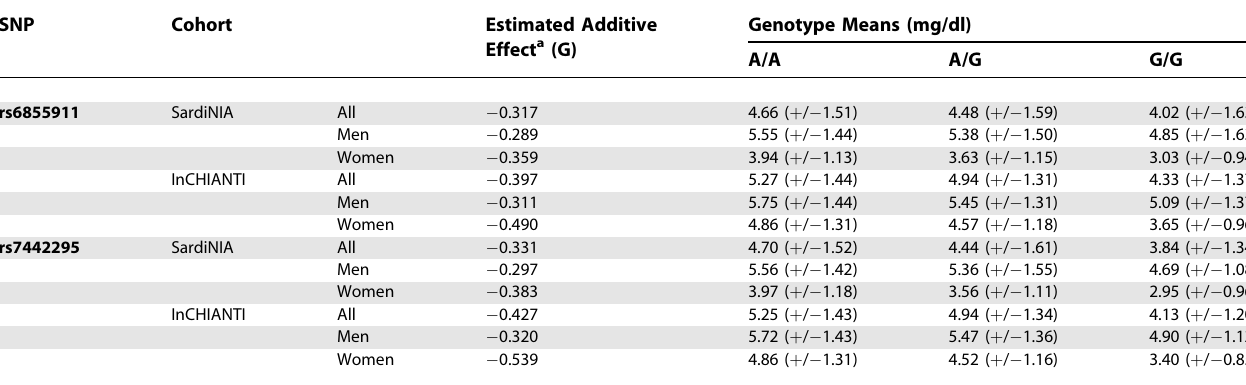
Table 1. Effect Sizes of Two SNPs in GLUT9 on UA Levels in Sardinian and InCHIANTI Cohorts SNP